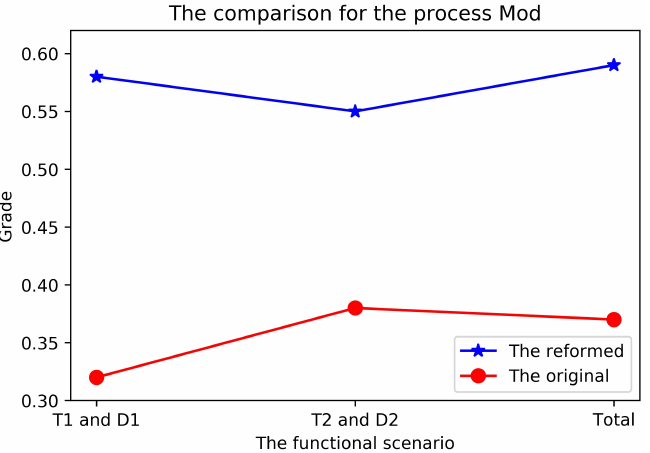
Figure 5. The grade of the mutated and